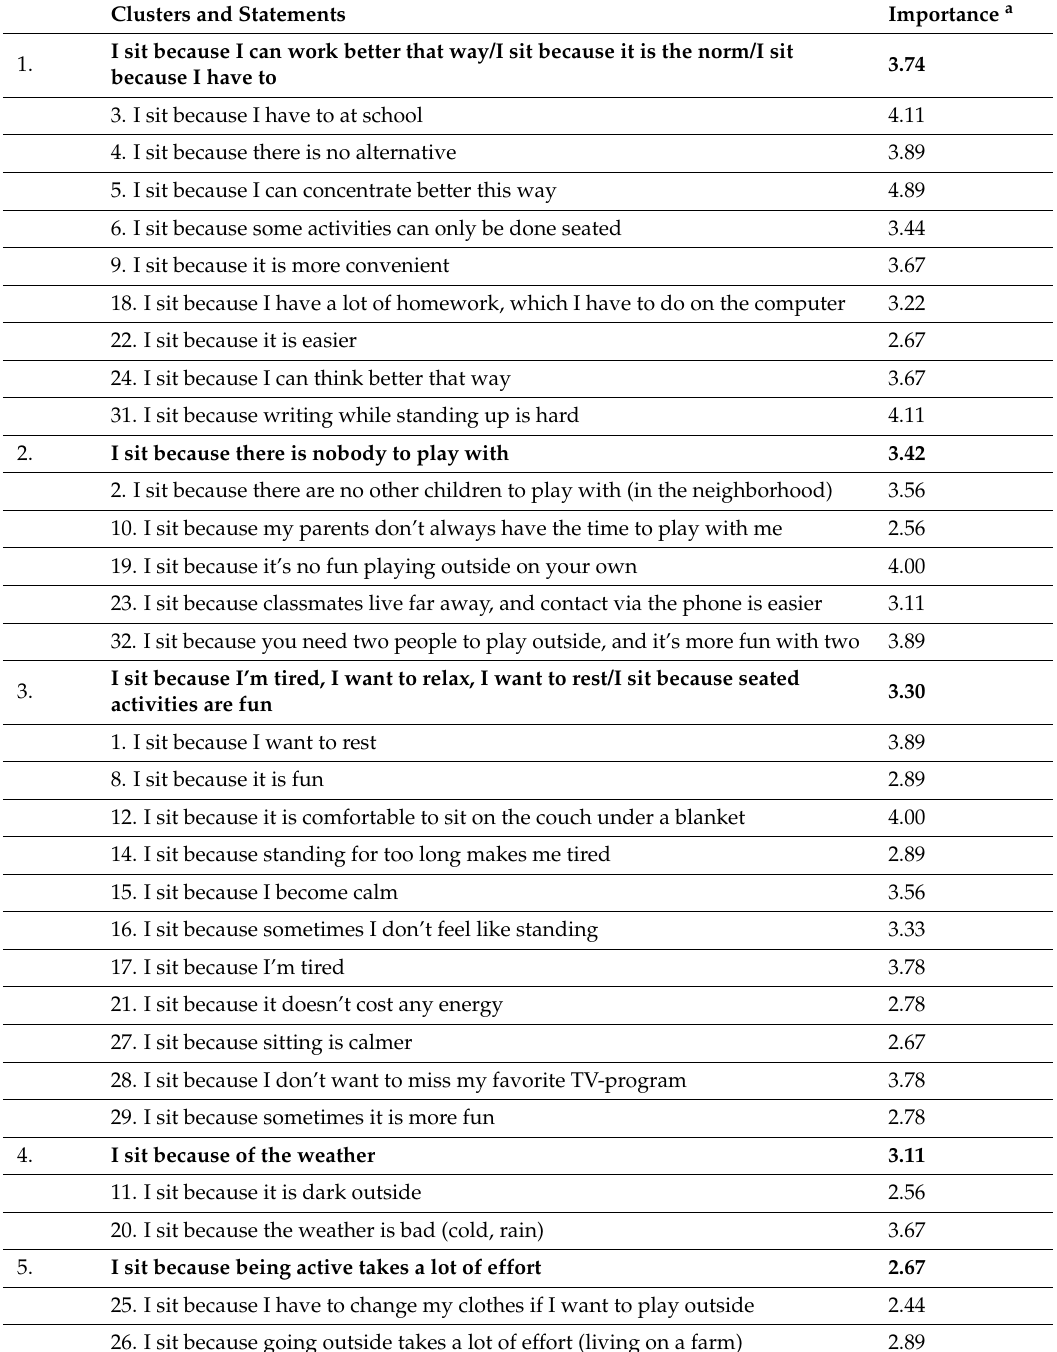
Table A2. Clusters, statements and importance ratings of children (school